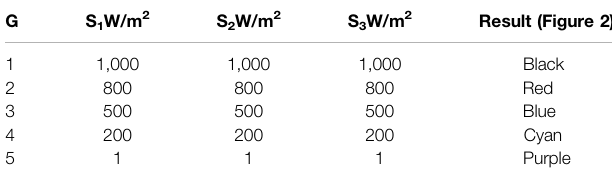
TABLE 1 | PV arrays under the same temperature and different voltage values (illumination